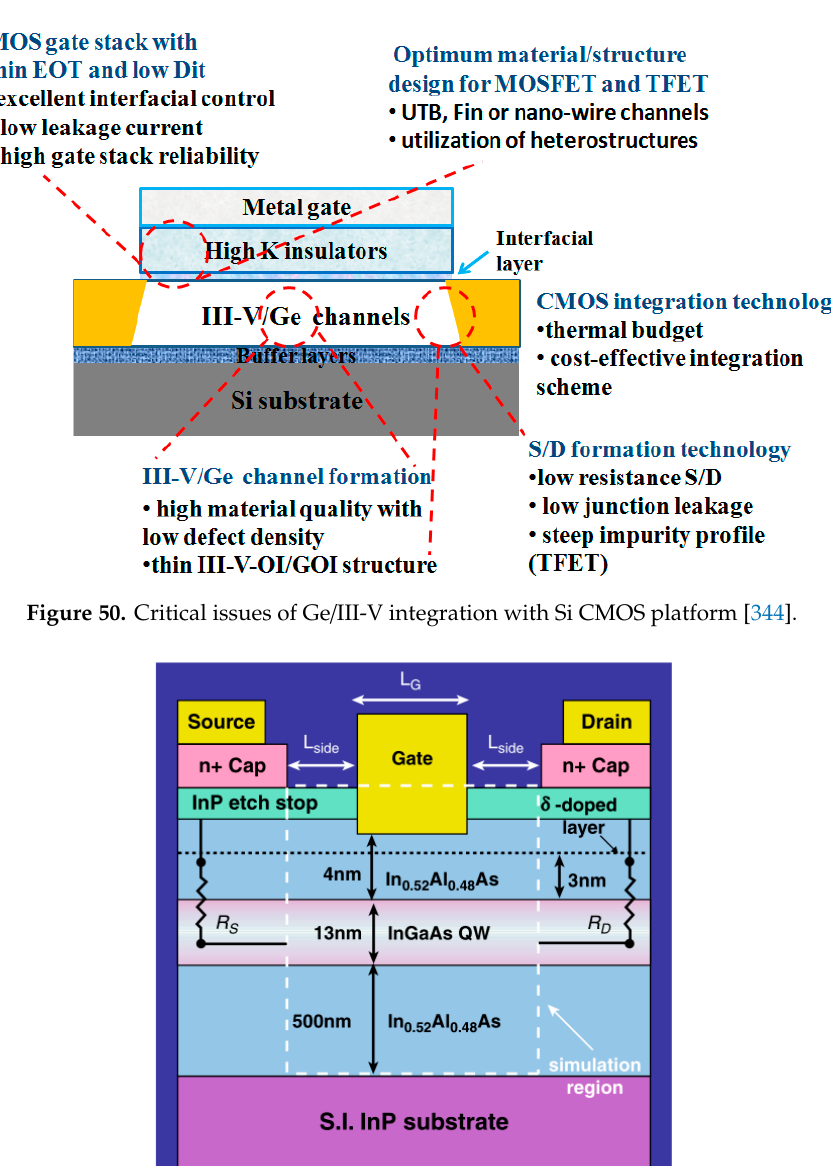
Figure 51. The structure of InGaAs high electron mobility transistors (HEMTs) designed for logic applications [345].